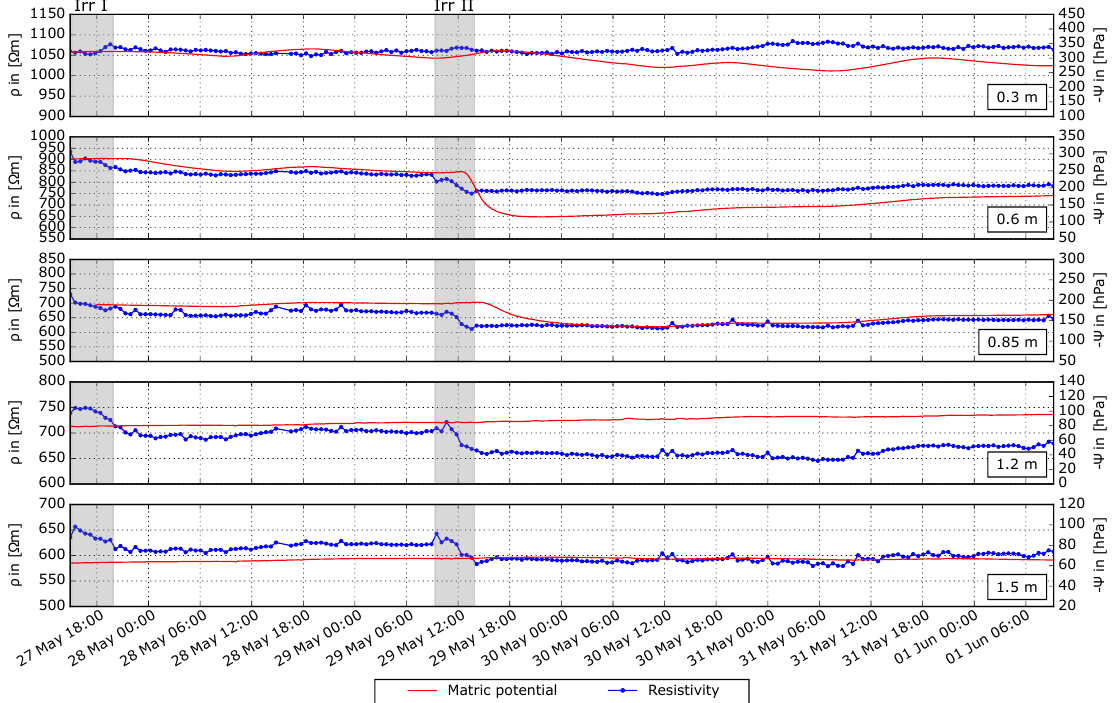
Figure 5. Variation of matric potential and co-located resistivity at different depths in 2.5m distance downslope of the irrigation